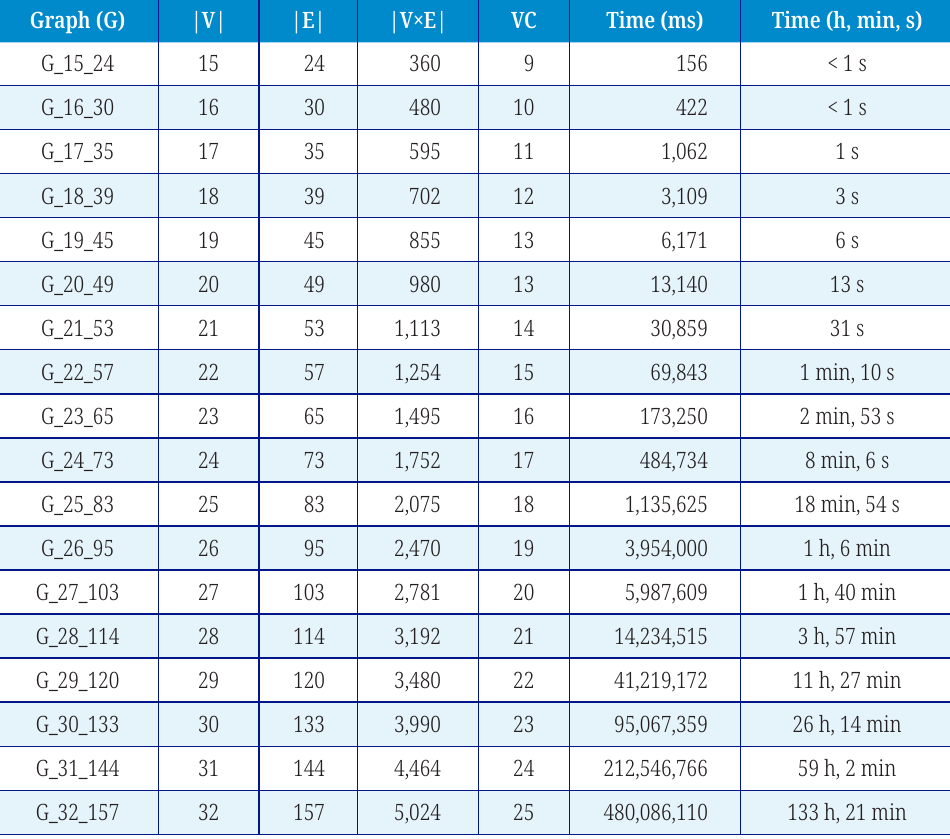
Table 1. Summary results after running the exact